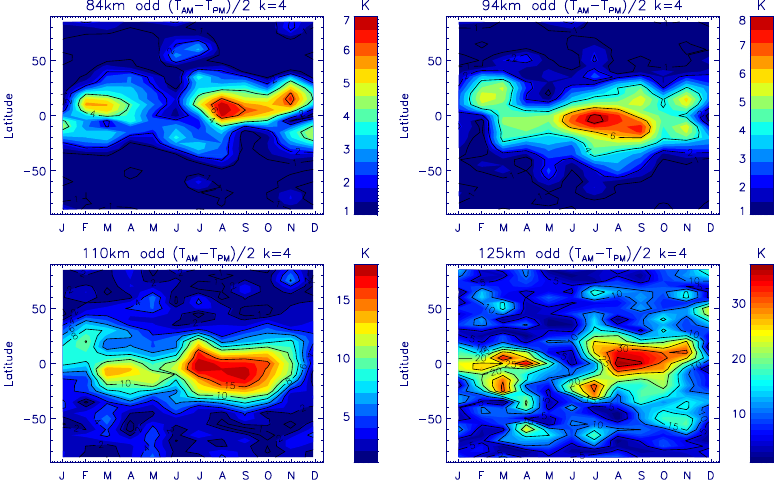
Figure 12. Time series of latitudinal distribution of average (2007–2012) monthly means amplitudes for the MIPAS | n odd − s | = 4 mode at 84, 94, 110 and 125km. DE3 and TE1 tidal oscillations are